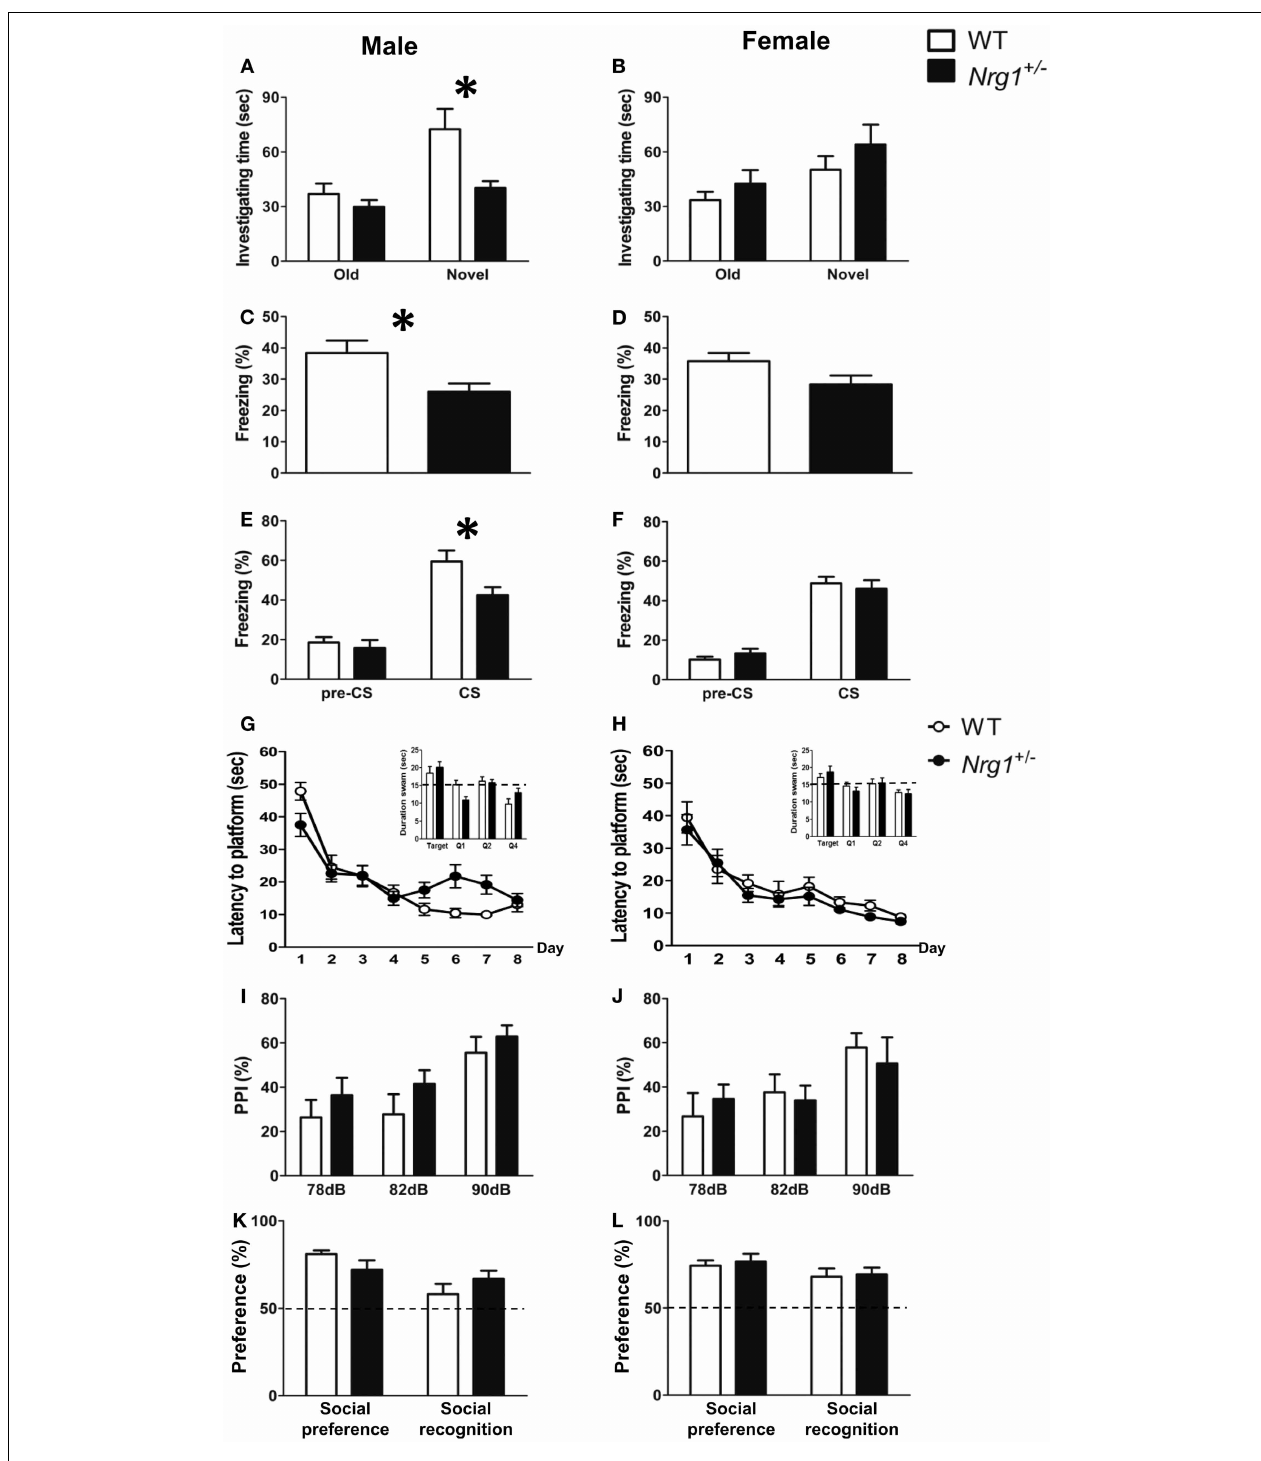
in male, but not female, TMc- Nrg1 + / − mice. (E,F) In the cued fear conditioning task, a reduction in freezing time percentage (%) was found in male, but not female, TMc- Nrg1 + / − mice. In contrast, no significant genotype-dependent differences were found in the Morris water maze, prepulse inhibition task, or the social task in either males (G,I,K) or females (H,J,L) , respectively. Dash lines indicate chance level. ∗ P < 0 . 05 between two